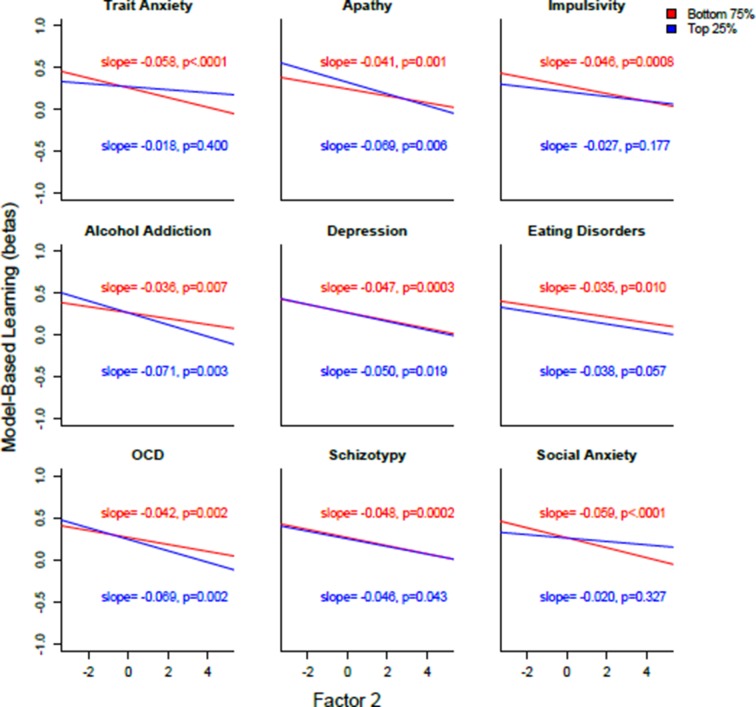
Plotted are the regression lines for 18 different analyses, where the population was split into the top 25% and bottom 75% for each of the nine clinical questionnaires.